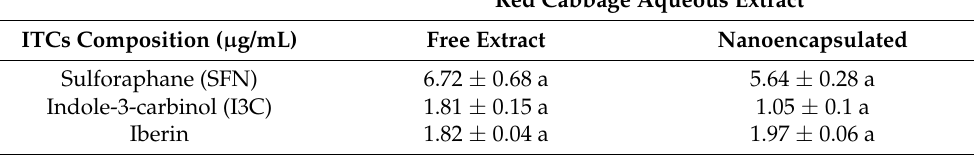
Table 2. Extract composition of the red cabbage aqueous extract for the free and the nanoencapsulated treatment. The numbers show the average values ( n = 3) ± standard error. Different letters in a row indicate statistically significant differences in the HSD Tukey’s test ( p < 0.05). Red Cabbage Aqueous Extract ITCs Composition ( µ